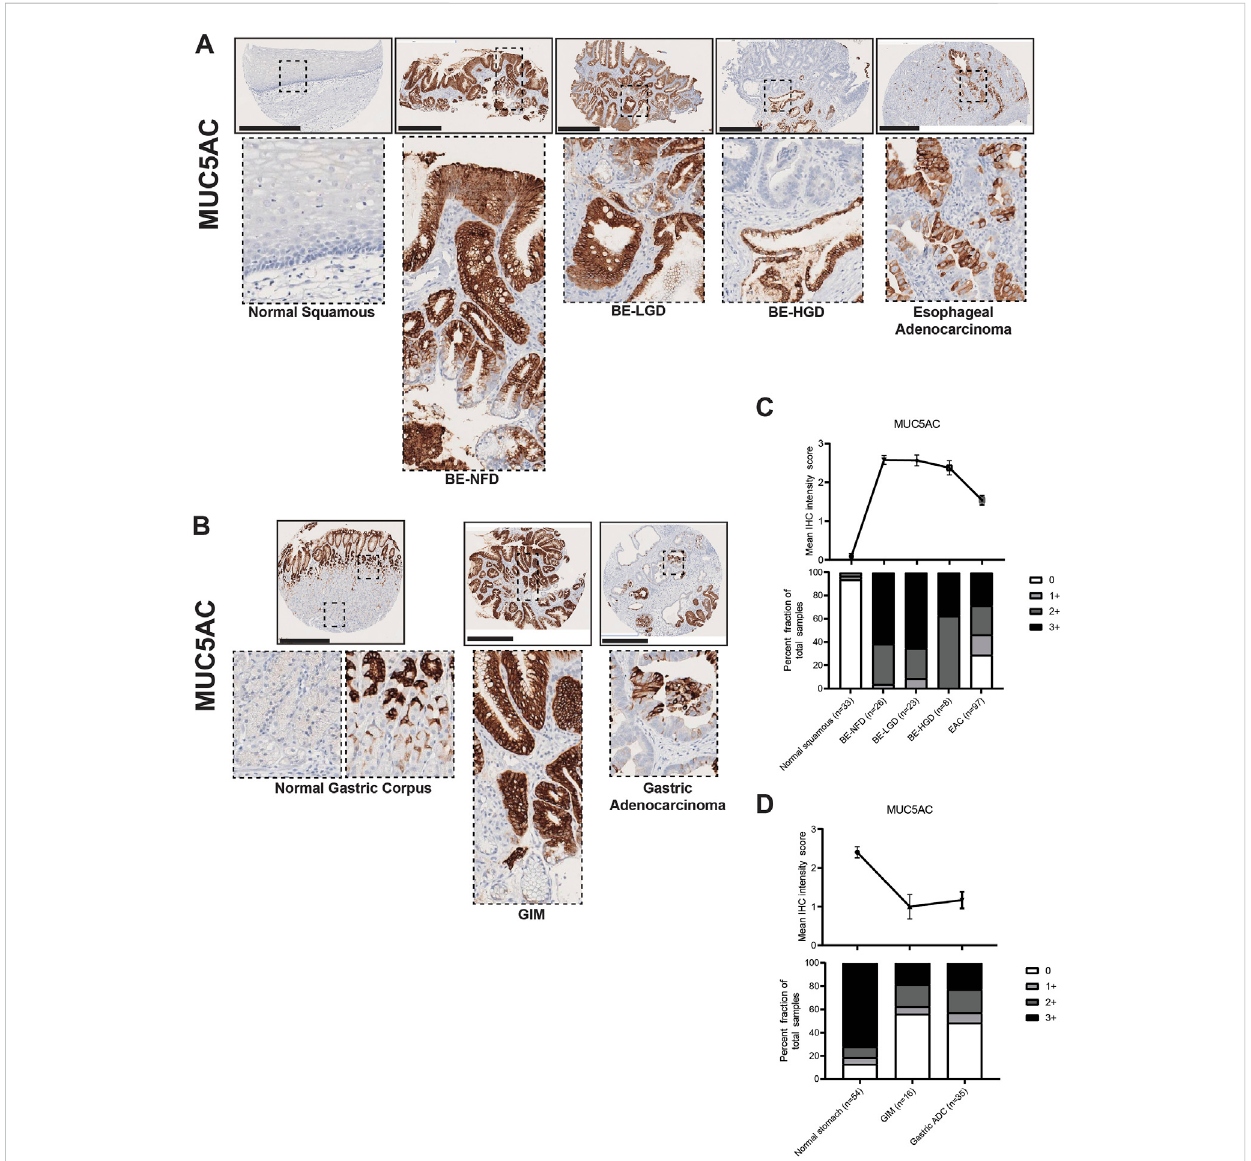
MUC5AC staining inhuman tissue microarray esophageal cases, inthesame sequence as inFigure 2A. (B) Immunohistochemistry ofMUC5AC staining in human tissue microarray gastriccases, inthe same sequence as in Figure 2B. All scale bars, 500 μ m. (C) Top: theMUC5ACaverage IHC intensity score of each esophageal phenotype is plotted in the same sequence as in Figure 2C. Bottom: the MUC5AC fraction of esophageal tissue cores with each score is plotted in the same sequence as in Figure 2C. Each phenotype ’ s total tissue core number is provided at the bottom of each column. (D) Top: the MUC5AC average IHC intensity score of each esophageal phenotype is plotted in the same sequence as in Figure 2D. Bottom: the MUC5AC fraction of esophageal tissue cores with each score is plotted in the same sequence as in Figure 2D. Each phenotype ’ s total tissue core number is provided at the bottom of each